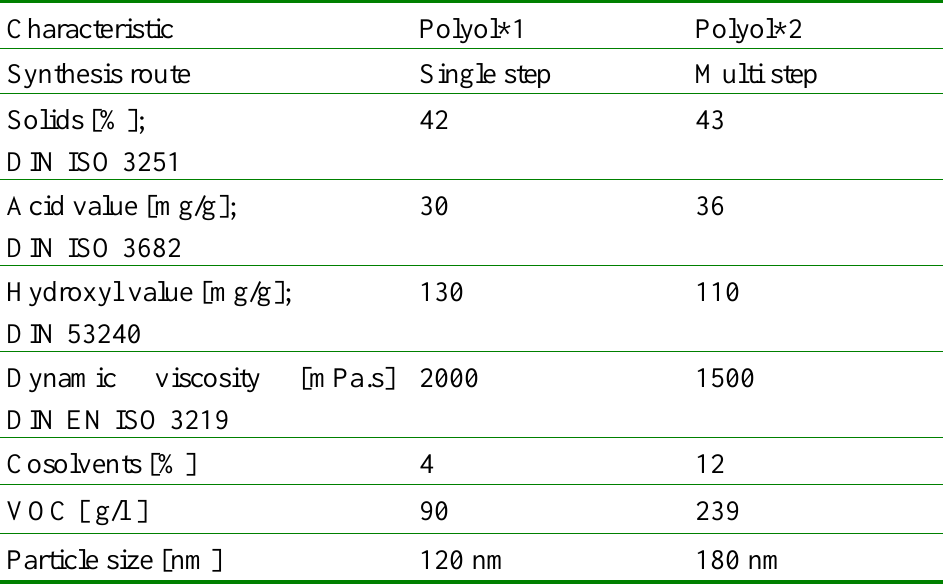
Table 1. Characterization of the acrylic polyol dispersions [15].